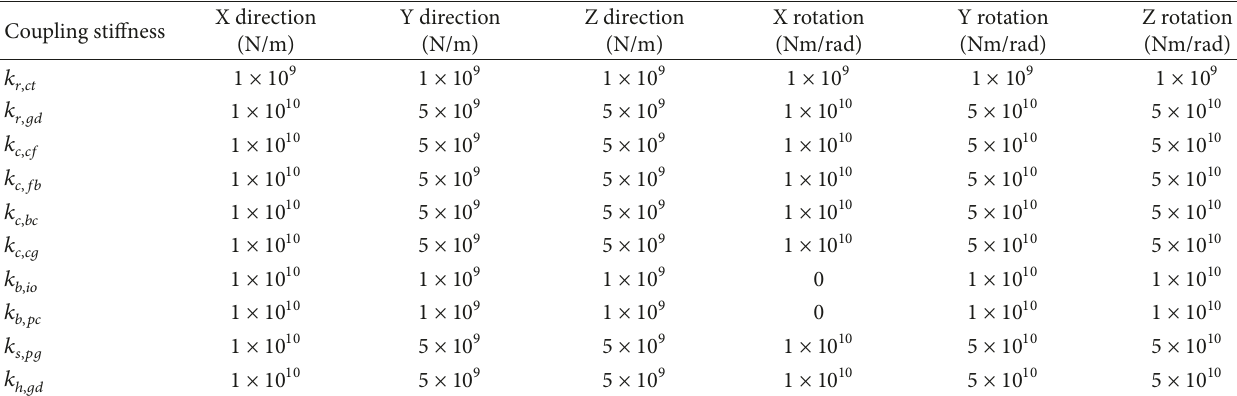
Table 5: Coupling stiffness in the example cutter head driving